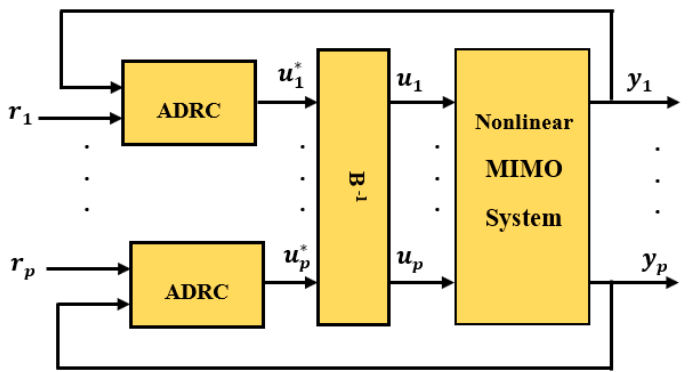
Figure 3. The decoupled ADRC control scheme, where each ADRC block involves a SISO connection of a tracking differentiator (TD), nonlinear state error feedback (NLSEF), and an extended state observer (ESO), as in Figure 1 [23].